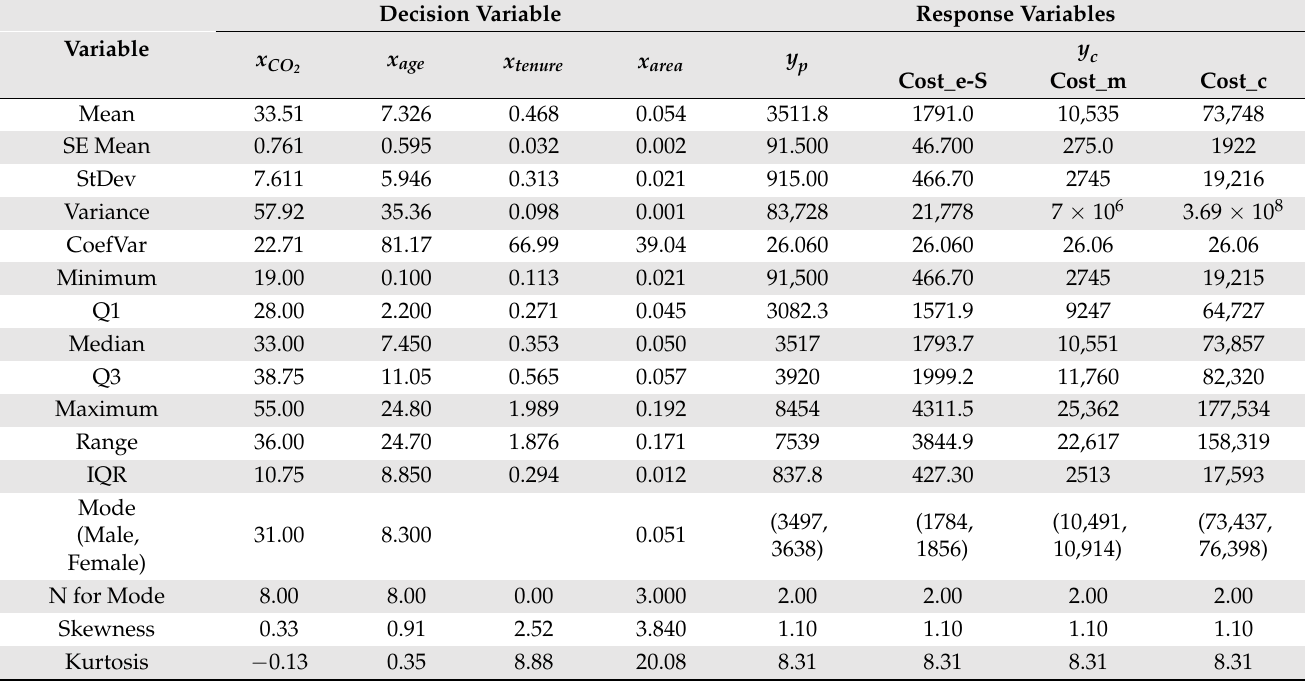
Table 3. Descriptive statistics of the variables of the e-scooter